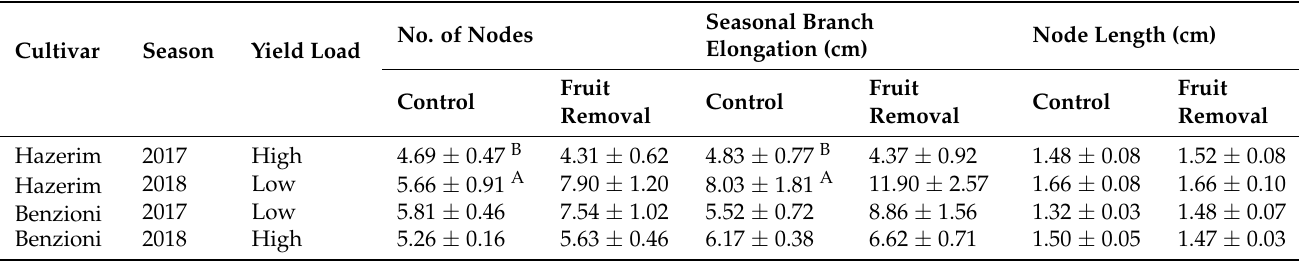
* represents a significant difference ( P < 0.05, t -test) between years for the same treatment of the same cultivar. No significant difference was found between treatments. Different letters represent a significant effect of the year ( P < 0.05, two-way ANOVA). The treatment or the interaction between year and treatment did not have a significant